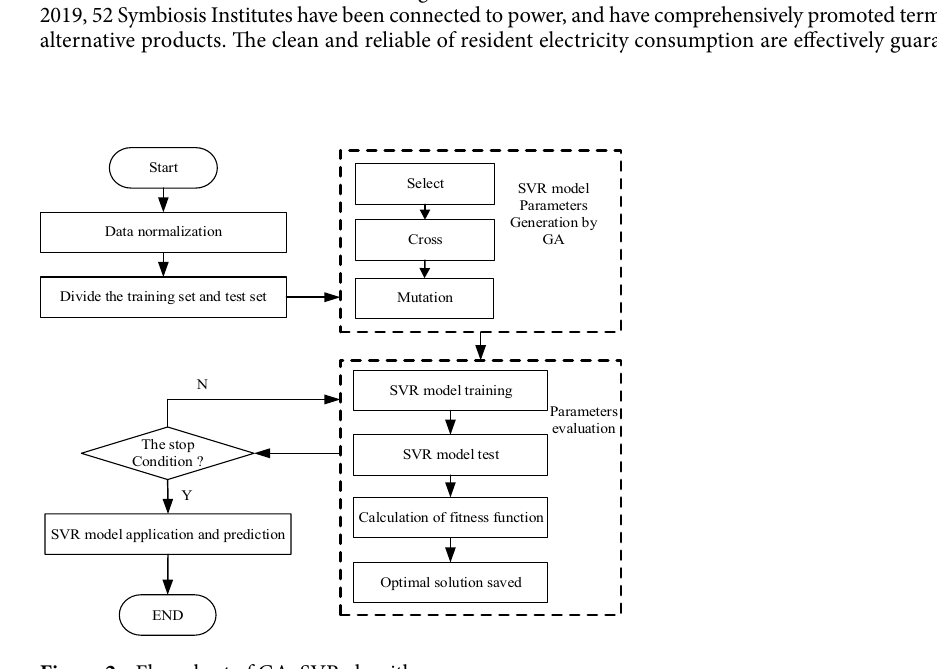
Figure 2. Flow chart of GA–SVR